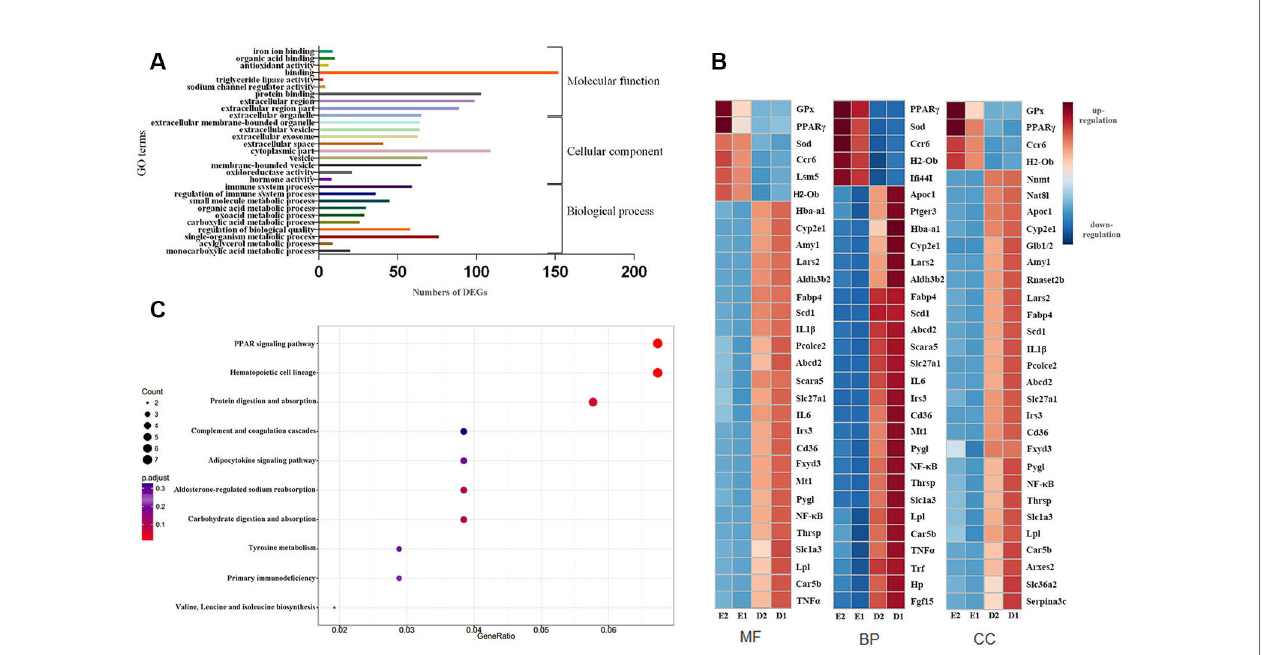
FIGURE 5 | GO and KEGG analysis of DEGs. (A) The top 10 GO terms of BP, MF, and CC. (B) The top 30 DEGs heatmaps of BP, MF, and CC. (C) 15 pathways of DEGs using KEGG enrichment